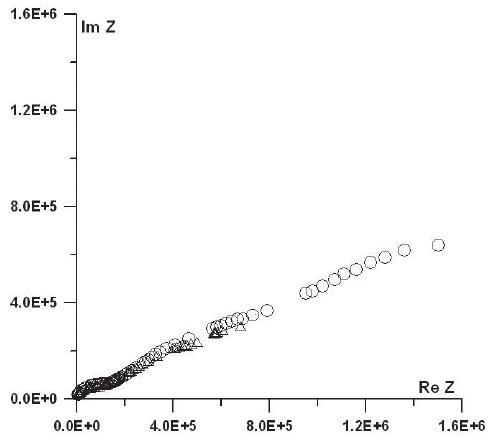
Fig. 8. The complex resistivity plane representation of the sample for relative saturations 50% ( ), 55% ( ), respectively.